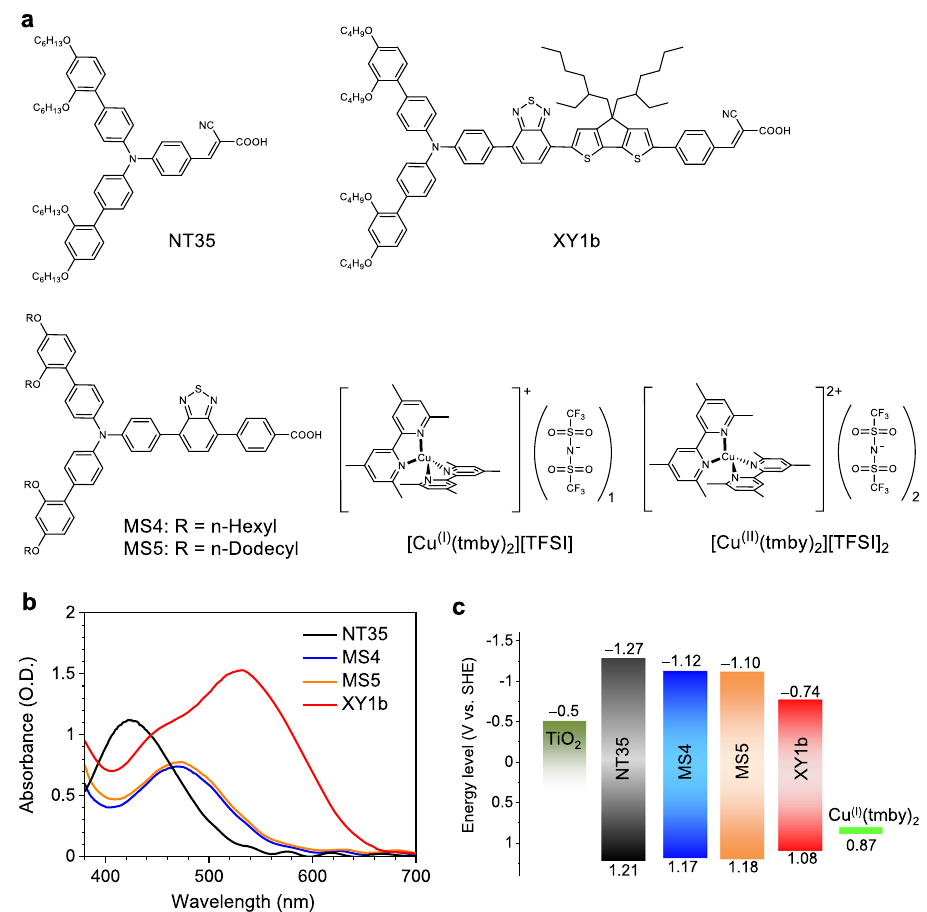
Fig. 1 Dye molecular structures and their optical and electronic properties. a Molecular structures of dyes (NT35, MS4, MS5, and XY1b) and copper complex ([Cu (I) (tmby) 2 ][TFSI] and [Cu (II) (tmby) 2 ][TFSI] 2 , tmby = 4,4 ′ ,6,6 ′ -tetramethyl-2,2 ′ -bipyridine; TFSI = bis(tri fl uoromethylsulfonyl)imide). b UV – Vis absorption spectra of NT35, MS4, MS5, and XY1b adsorbed on 2.2 μ m thick transparent TiO 2 fi lms. c Energy levels diagram of TiO 2 , dyes, and [Cu (I) tmby) 2